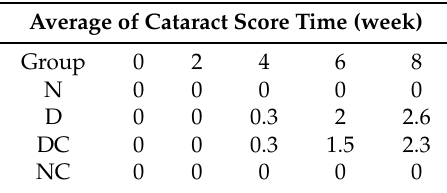
Table 1. The effect of crocin(s) on the average lens opacity in each group at different weeks. Average of Cataract Score Time (week)